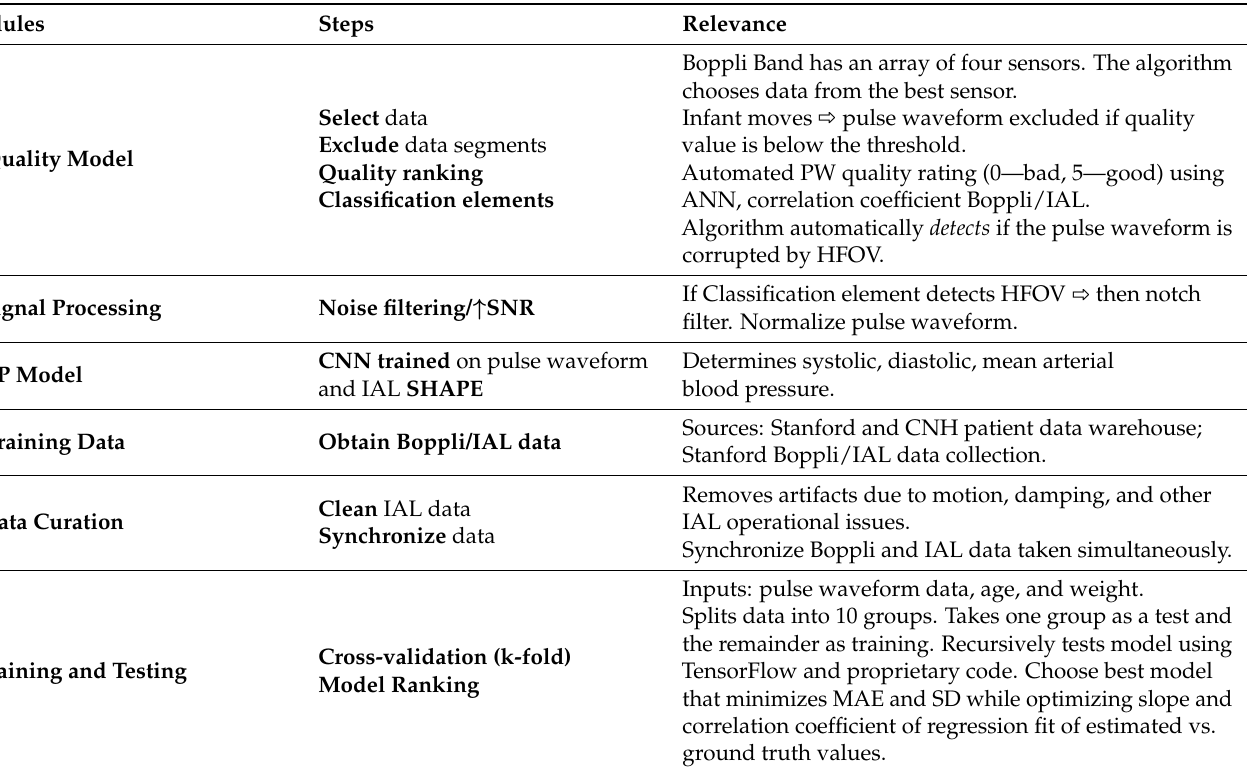
Figure 2. Overview of the working of the sensor and steps to infer blood pressure. Table 2. Pipeline for real-time processing of pulse waveforms and artificial neural network (ANN) Table 2. Pipeline for real-time processing of pulse waveforms and arti fi cial neural network (ANN) training. training.